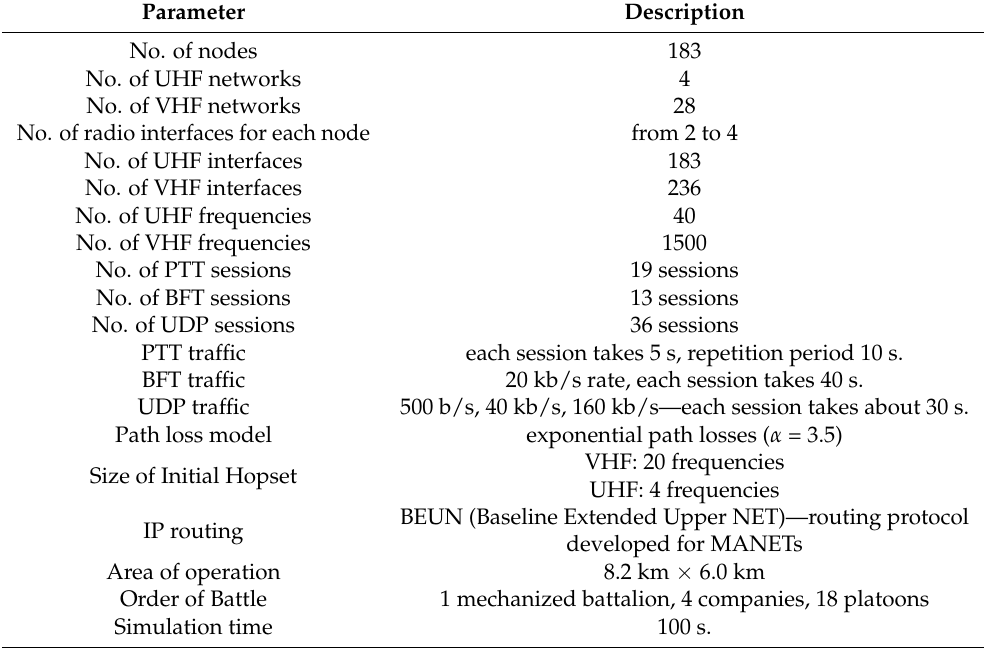
Table 2. Simulation